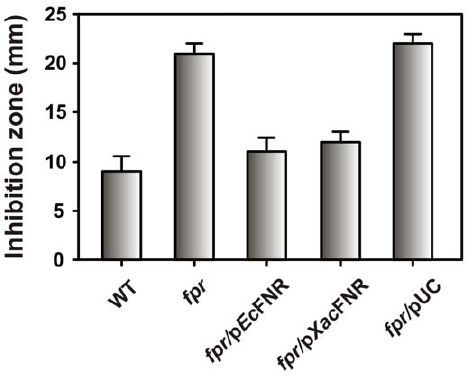
Figure 2. Complementation of the E.colifpr -null mutant with Xac -FNR. The E. coli fpr strain (RR6A) was transformed with p Ec FNR that contained the endogenous fpr gene, p Xac FNR that contained the Xac fpr gene, or pUC119. The susceptibility of E. coli strains to MV toxicity was evaluated using the disk diffusion assay. The diameters of the inhibition zones were measured after 24 h of incubation. Bars indicate mean 6 standard deviation of three independent experiments.